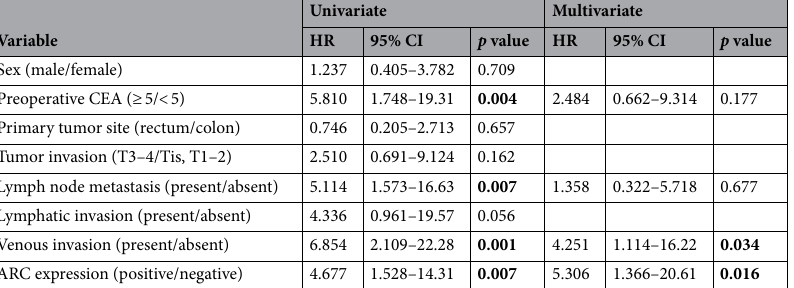
Table 2. Univariate and multivariate analyses of relapse-free survival. HR hazard ratio, CI confidence interval, CEA carcinoembryonic antigen. HR and 95%CI of histological grade cannot be calculated because none of the five patients with Por or Muc had cancer relapse. Bold values indicate p <